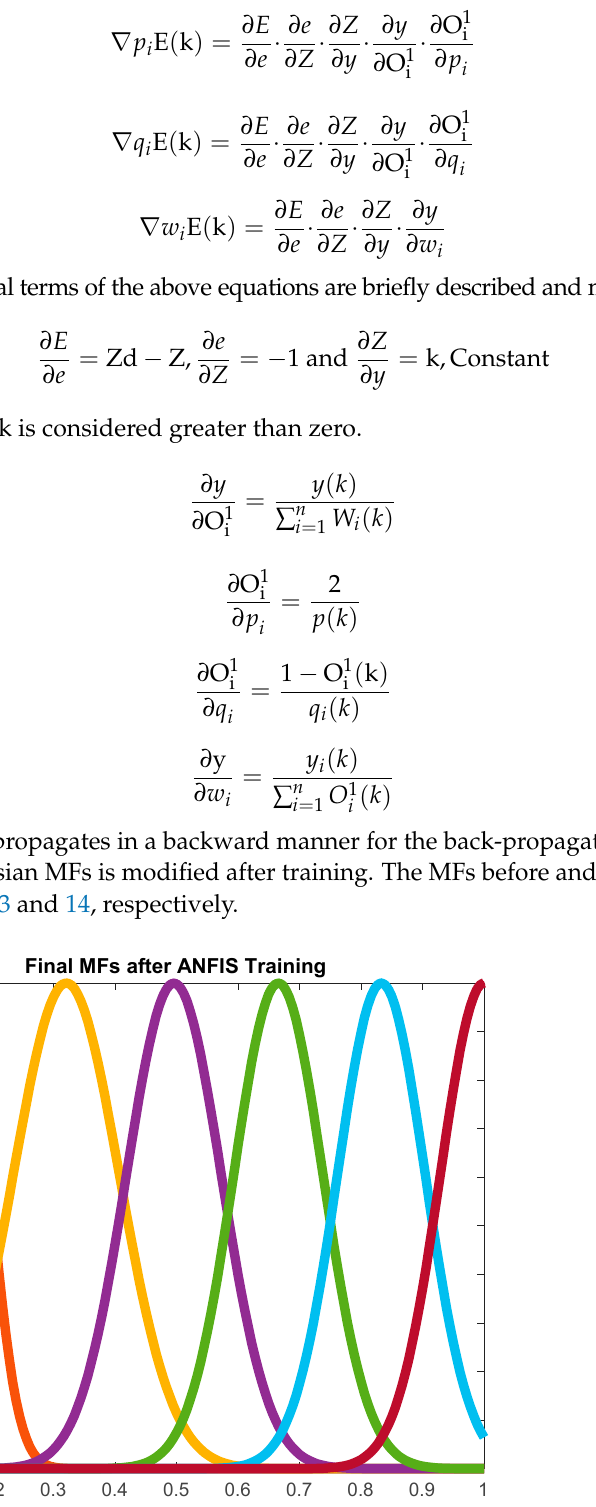
Figure 15. Training error curve of proposed ANFIS control for depth plane. Figure 16. Training error curve of proposed ANFIS control for heading plane. After training the input data, the fi ve-layer Simulink structure of the ANFIS model is obtained, and it is shown in Figure 17. To be tt er understand the implementation process of the ANFIS model, it is brie fl y explained in the fl ow chart illustrated in Figure 18. Ini- tially, the depth plane parameters are considered as input training data, and each input is de fi ned with MFs. In next step, the number of epochs and percentage of training data are described for training the model. After, the successful training yields the best FIS and training results of ANFIS model, which is mentioned in third step. In the fi nal step,